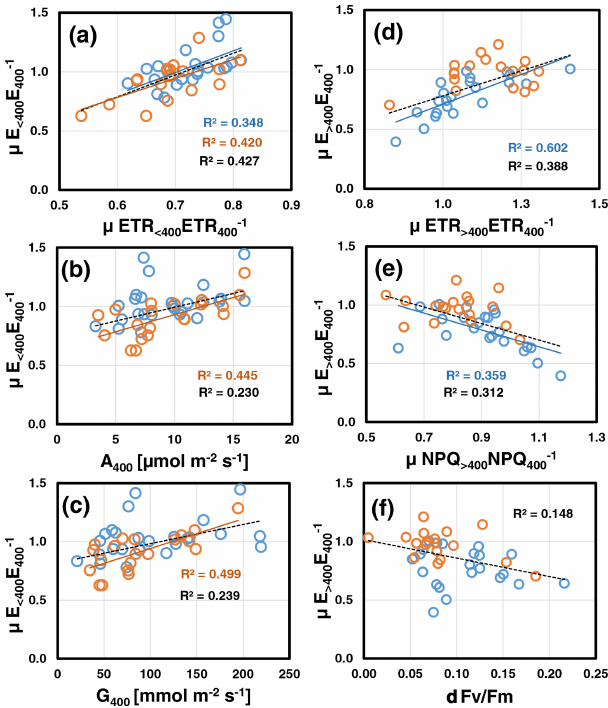
Figure 3. Key relations of relative emissions to low CO 2 ( µE < 400 E − 1 ; a, b, c ) and high CO 2 ( µE > 400 E − 1 ; d, e, f ) mea- 400 400 sured at assay temperatures of 30 ◦ C (blue) and 35 ◦ C (red). Lines with determination coefficients R 2 show best-fit results from Pear- son correlation analyses with P< 0 . 05 (lines and R 2 in black are from pooled data). For a complete overview, see Table S3b and Fig. S7 in Supplement